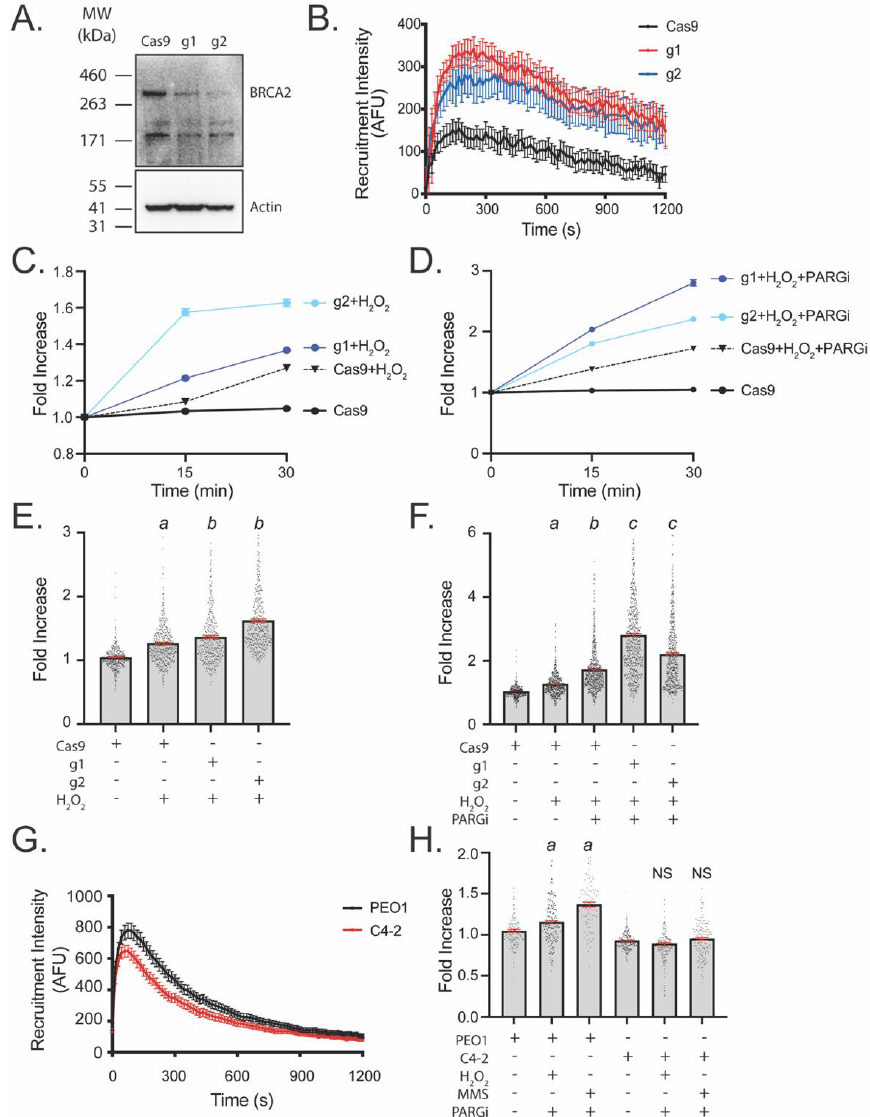
Figure 3 . Enhanced PARylation in BRCA2-deficient cell lines. ( A ) Validation of A549/BRCA2-deficient cell lines. CRISPR/Cas9-mediated BRCA2 deficiencies were generated using 2 unique gRNAs (i.e., g1, g2). ( B ) Laser micro-irradiation of A549/Cas9 or A549/BRCA2-deficient cells; N 40 cells.